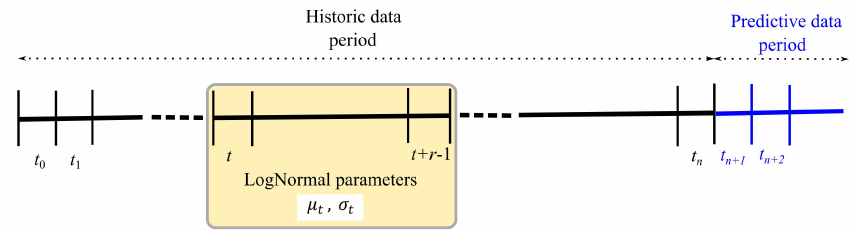
Figure 1. Time line showing a window of length r quarters in n quarters of historic data. The yellow highlight shows a window spanning the period t to t + r − 1, for which the fitted lognormal parameters are µ t and σ t . Windows that use only historic data are indicated in black, and windows that use some predicted data are indicated in blue.